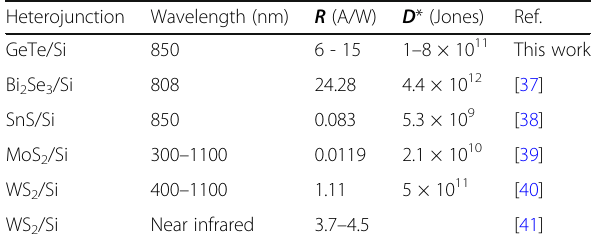
Table 1 Comparison of responsivity and detectivity of infrared photodetectors based on other materials